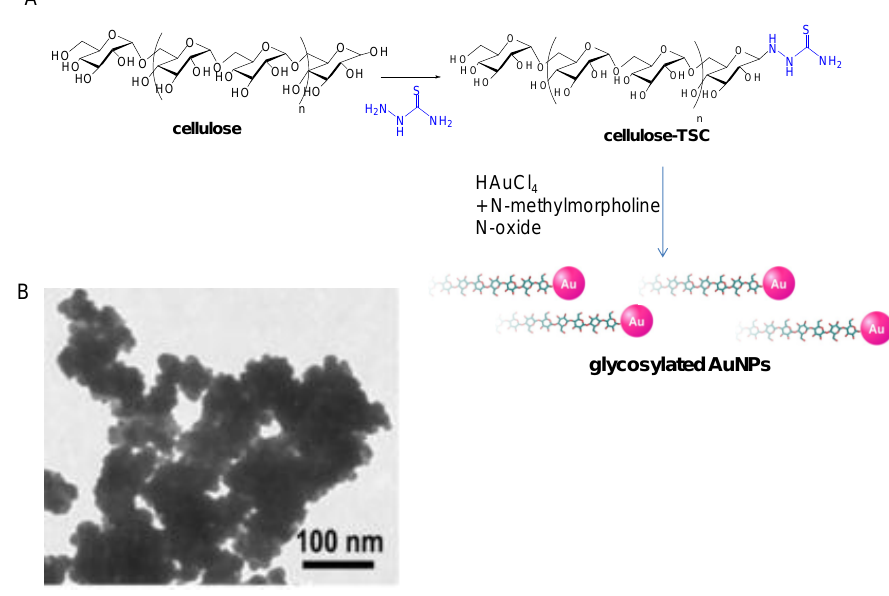
Figure 4. Synthesis of glycosylated AuNPs. ( A ) Synthetic scheme; ( B ) TEM image of glyco-AgNPs.